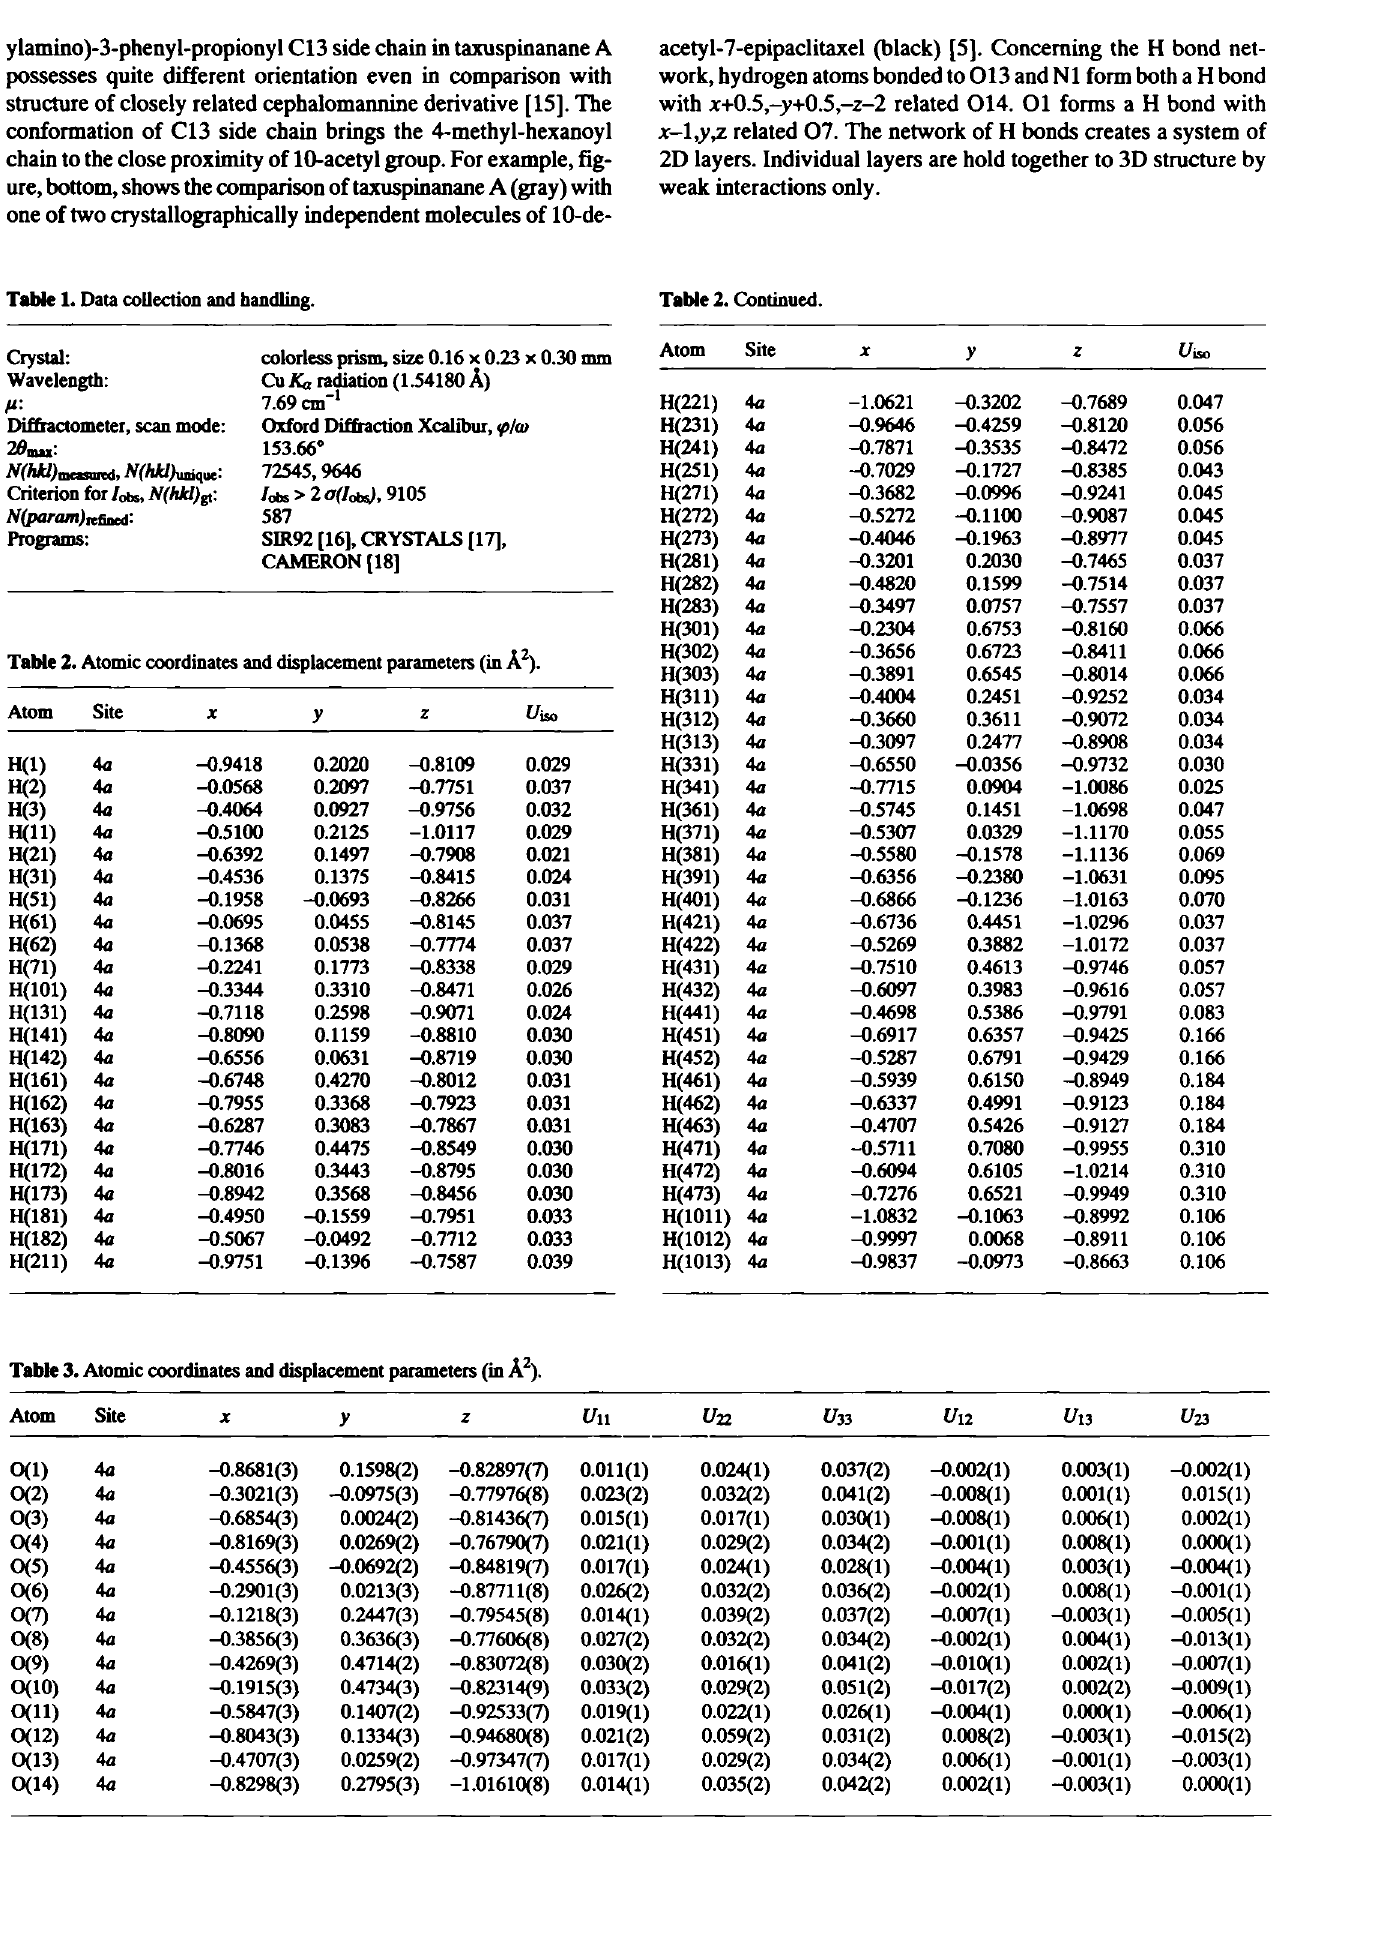
Table 3. Atomic coordinates and displacement parameters (in Ä 2